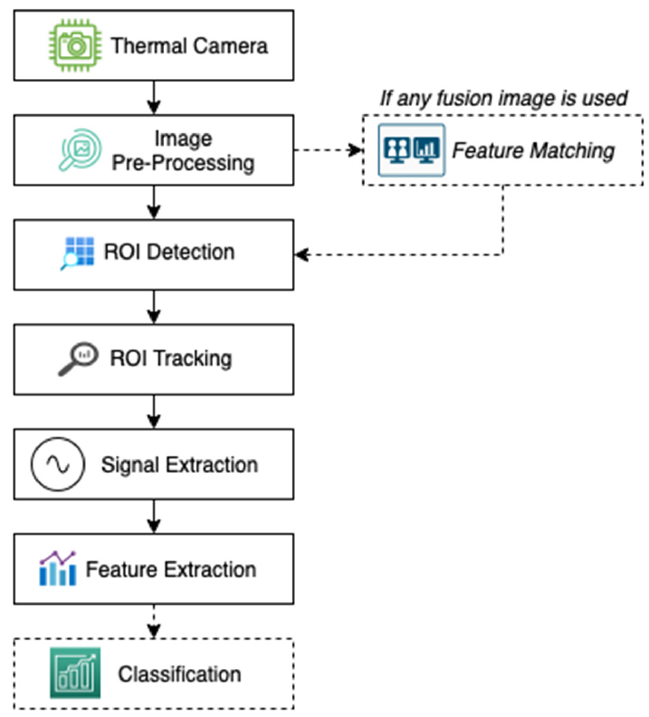
Figure 1. The general process stages of studies using a thermal camera that performs physiological measurements. Several stages are depicted by dotted line boxes explaining that these stages only apply in certain studies in general.